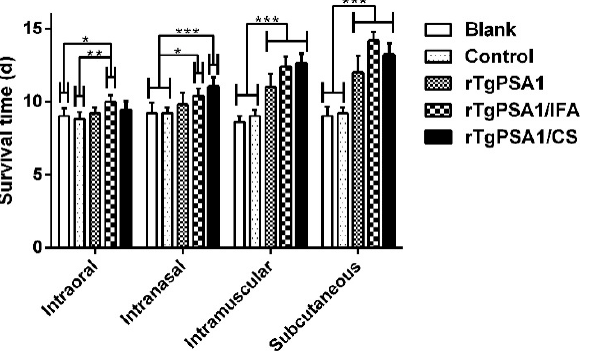
Figure 7. Mouse survival times with different administration routes. Two weeks after the last im- munization, mice were challenged with 200 newly prepared tachyzoites ( T. gondii RH strain) and survival time was recorded daily. Results were processed by Kaplan–Meier test and shown as mean ± SD (n = 5). Values between rTgPSA1/IFA and rTgPSA1/CS groups were compared with the independent t -test. * p < 0.05, ** p < 0.01, and *** p < 0.001 compared with blank or control group.